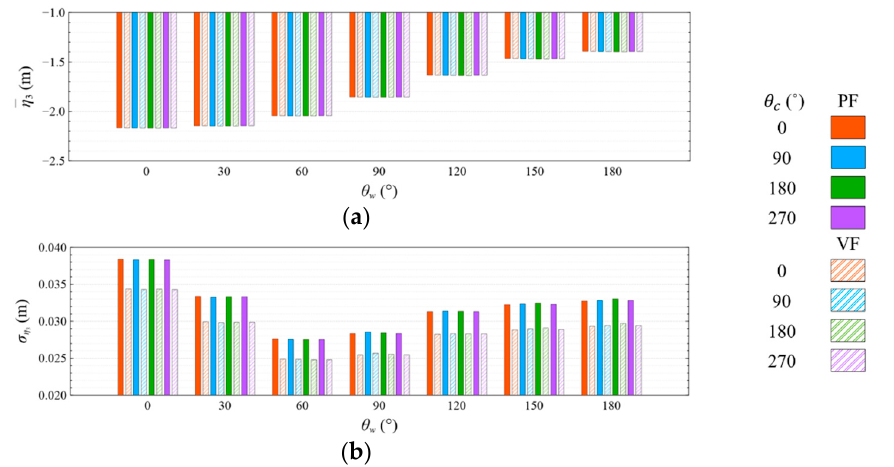
Figure 16. Comparison of ( a ) means and ( b ) standard deviations of platform heave motion under CW condition.